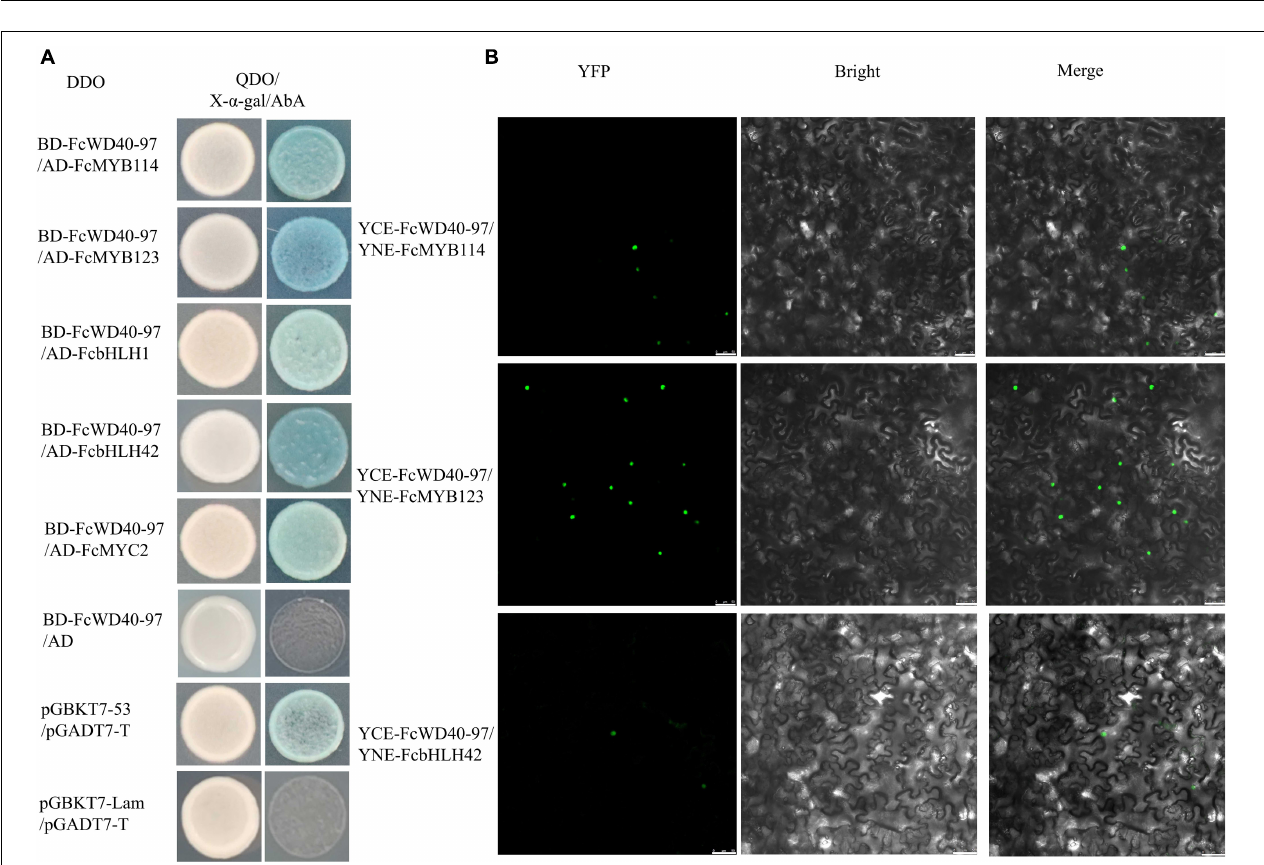
FIGURE 8 | Interaction of FcTTG1 with FcMYBs and FcbHLHs in vitro and in vivo . (A) Yeast two-hybrid test to determine the in vitro interaction with different constructs. (B) In vivo verification of interactions between FcTTG1 and FcMYB114, FcMYB123, and FcbHLH42. Bars = 50 µ m.